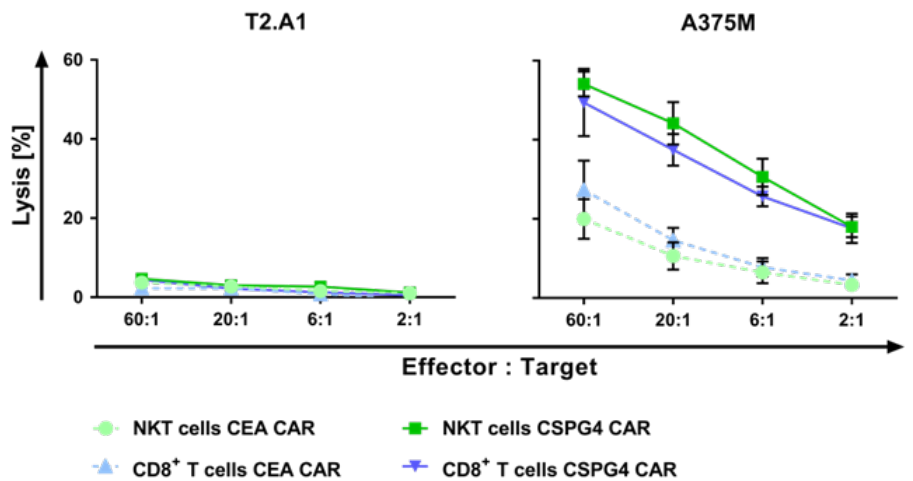
Figure 4. Melanoma cells are antigen-specifically lysed by the CSPG4 CAR-electroporated NKT cells. The NKT and CD8 + T cells were isolated and expanded as described for Figure 1. After 10 – 11 days, cell populations were either transfected with mRNA encoding a CEA-specific CAR or with mRNA coding for a CSPG4-specific CAR. The CEA CAR-transfected cells served as controls. Following overnight culture, the cytotoxicity of the receptor-transfected cells was determined in a standard 4 – 6 h 51 chromium release assay. The TxB cell hybridoma T2.A1 (CSPG4 − , CEA − ) and the A375M melanoma cell line (CSPG4 + , CEA − ) were used as target cells. The percentage of lysed cells was calculated for indicated effector-to-target (E/T) ratios. The receptor-electroporated NKT cells are shown in light green dotted lines (CEA CAR) and dark green solid lines (CSPG4 CAR), whereas the transfected CD8 + T cells are displayed in light blue dotted lines (CEA CAR) and dark blue solid lines (CSPG4 CAR). The data represent the mean values of 4–7 independent experiments ± SEM. The p -values were calculated by unpaired Student’s t -test and are listed in Tables S8 and S9.